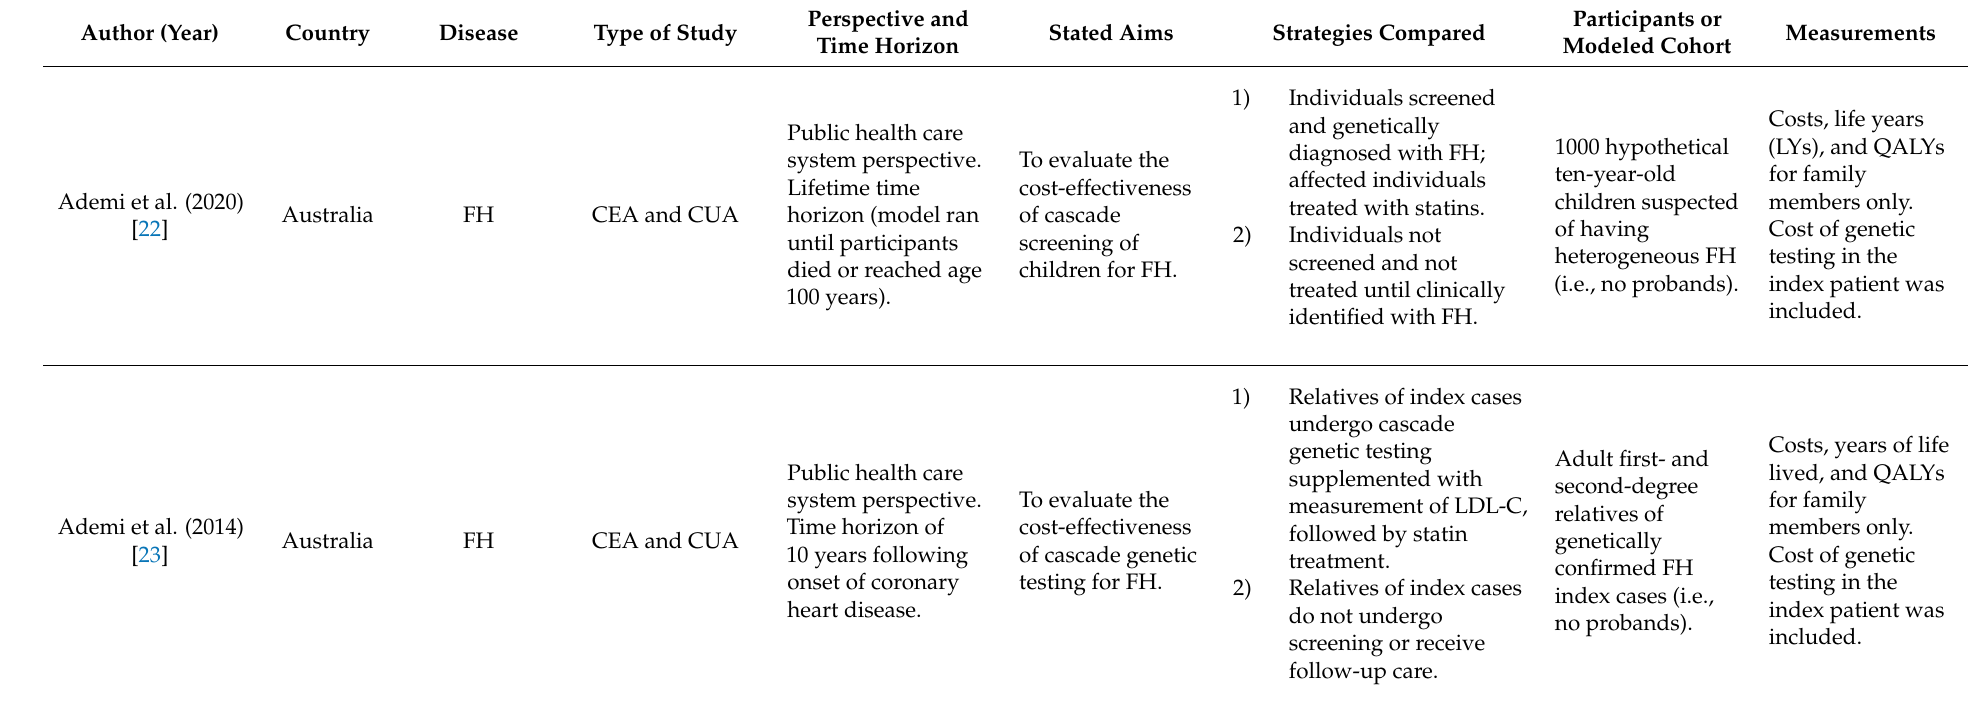
Table 1. Economic evaluations and cost analyses considering cascade costs and health effects of genetic